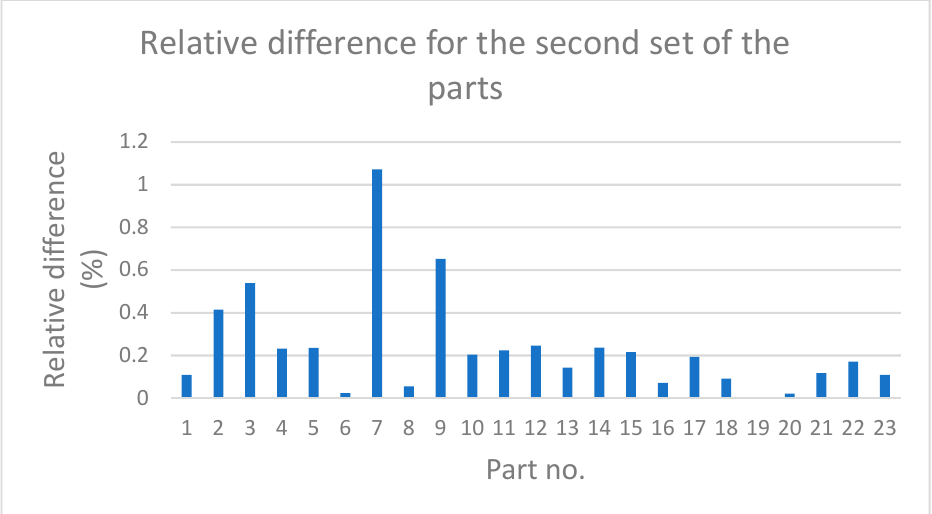
Figure 7. Relative difference between the values of deviations obtained with the use of the new and traditional methods for the second set of parts.